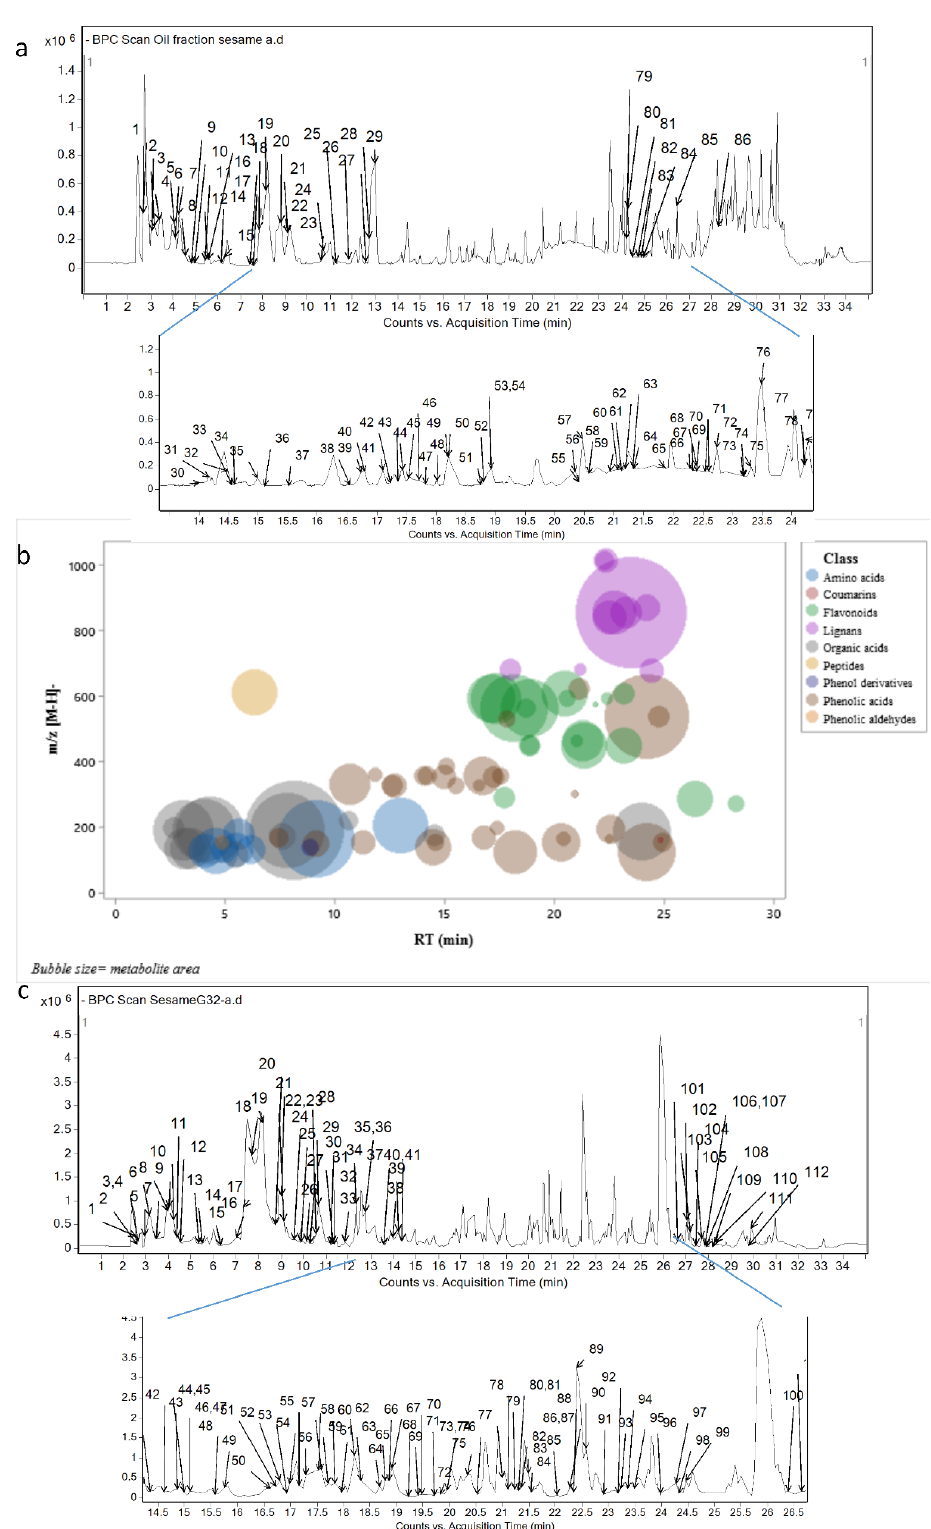
Figure 1. ( a ) Base peak chromatogram of SG32 oil and ( b ) its metabolites grouped into classes and classified according to m/z , retention time (RT), and relative area in SG32 oil. ( c ) Base peak chromatogram of SG32 cake, which has been adapted from [10].